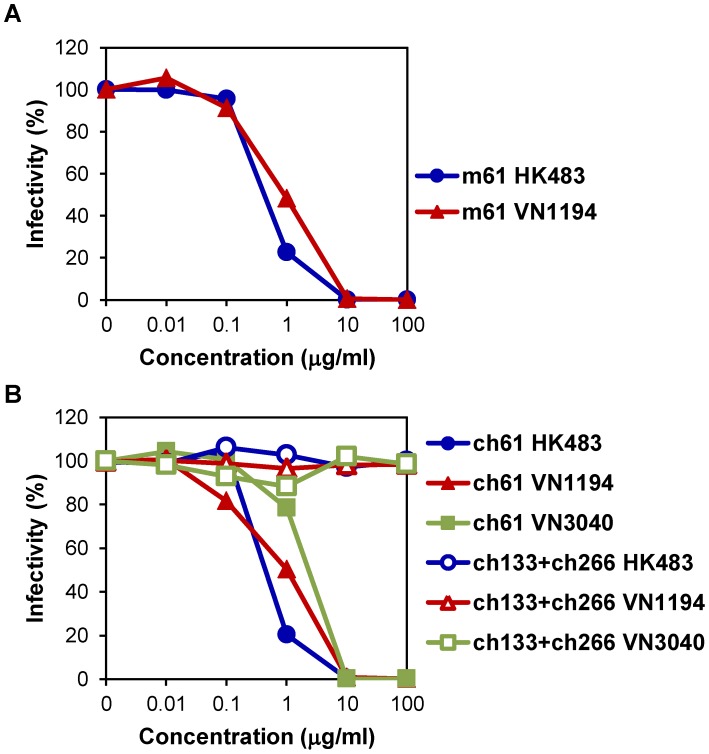
Neutralizing activities of MAbs m61 and ch61 against H5N1 HPAI viruses.Purified MAbs m61 (A) and ch61 (B) at the indicated concentrations were mixed with HK483, VN1194, or VN3040 and inoculated onto MDCK cells. A mixture of MAbs ch133 and ch226 was used as a control. The percentage of infectivity was calculated as follows: Infectivity (%) = the number of plaques with antibody/the number of plaques without antibody ×100. Averages of three independent experiments are shown.